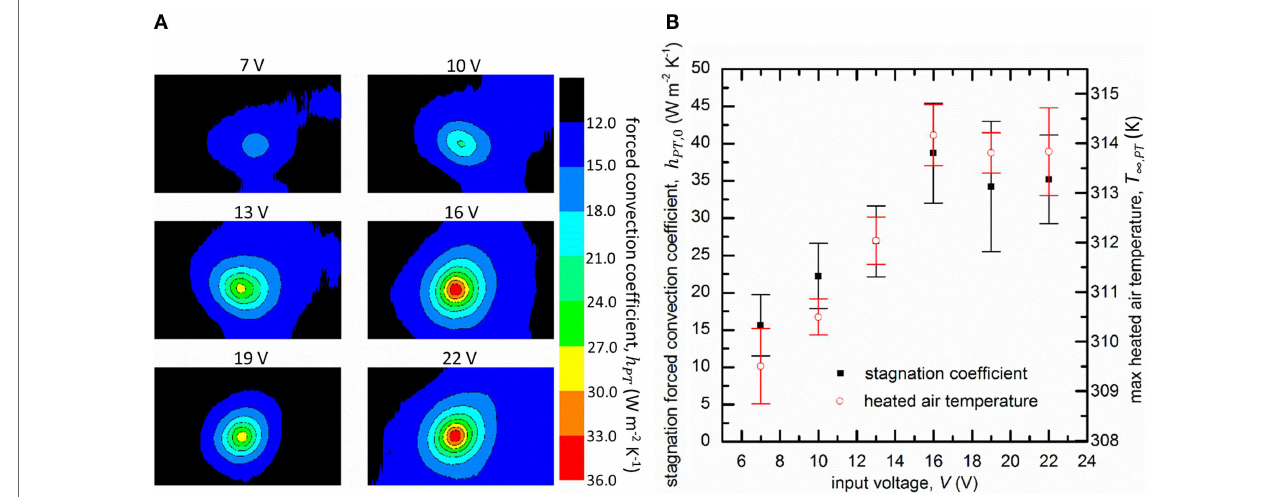
FIGURE 5 | (A) Contours of the local forced convection coefficient h PT for different input voltages to a sharpened PT. The gap distance was G = 1cm. (B) The local stagnation convection coefficient h PT,0 and the maximum heated air temperature T 1 ,PT as a function of the input voltage.